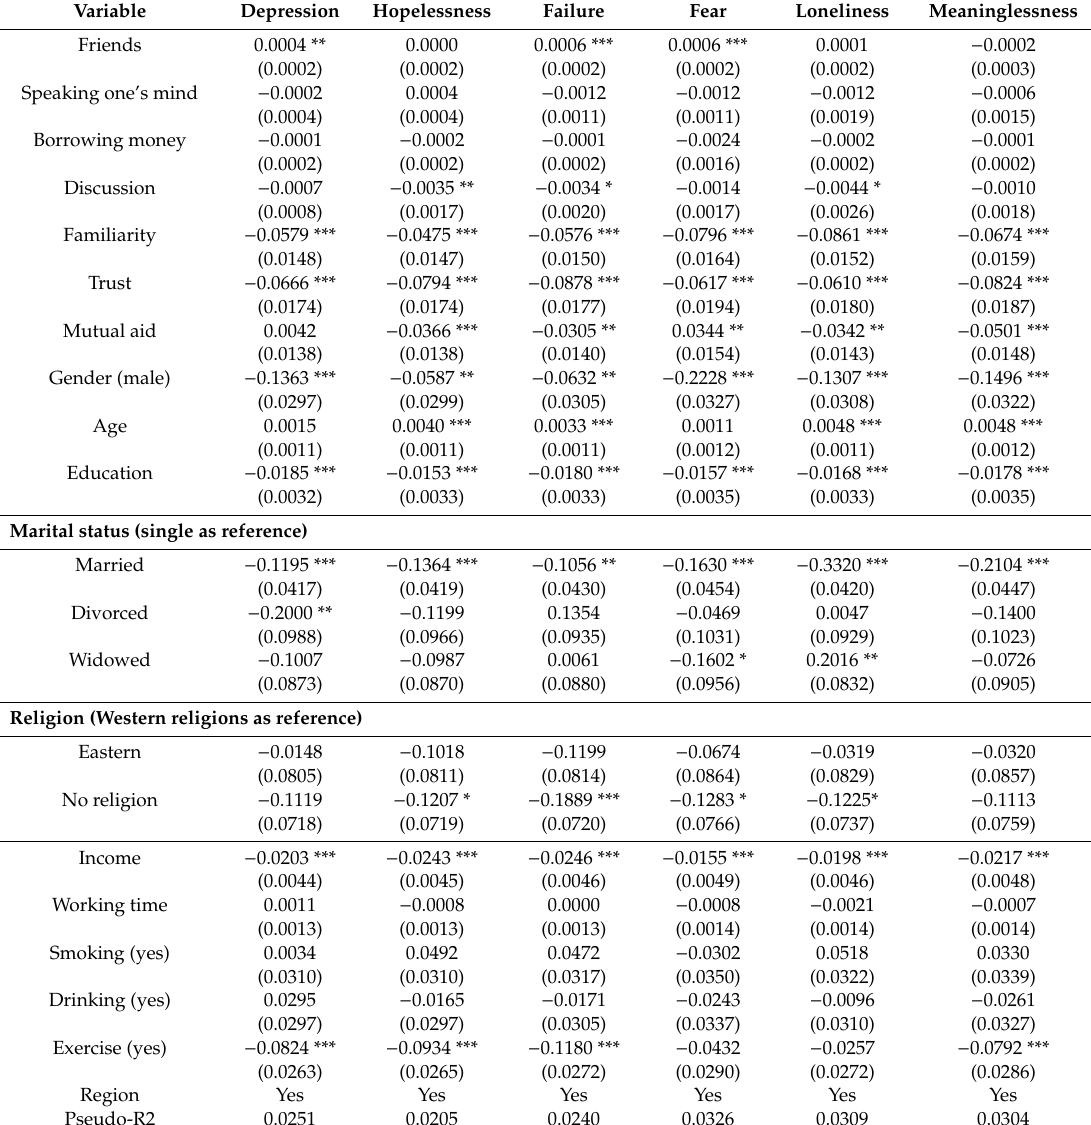
Table 3. Influence of social support on mental health ( N =